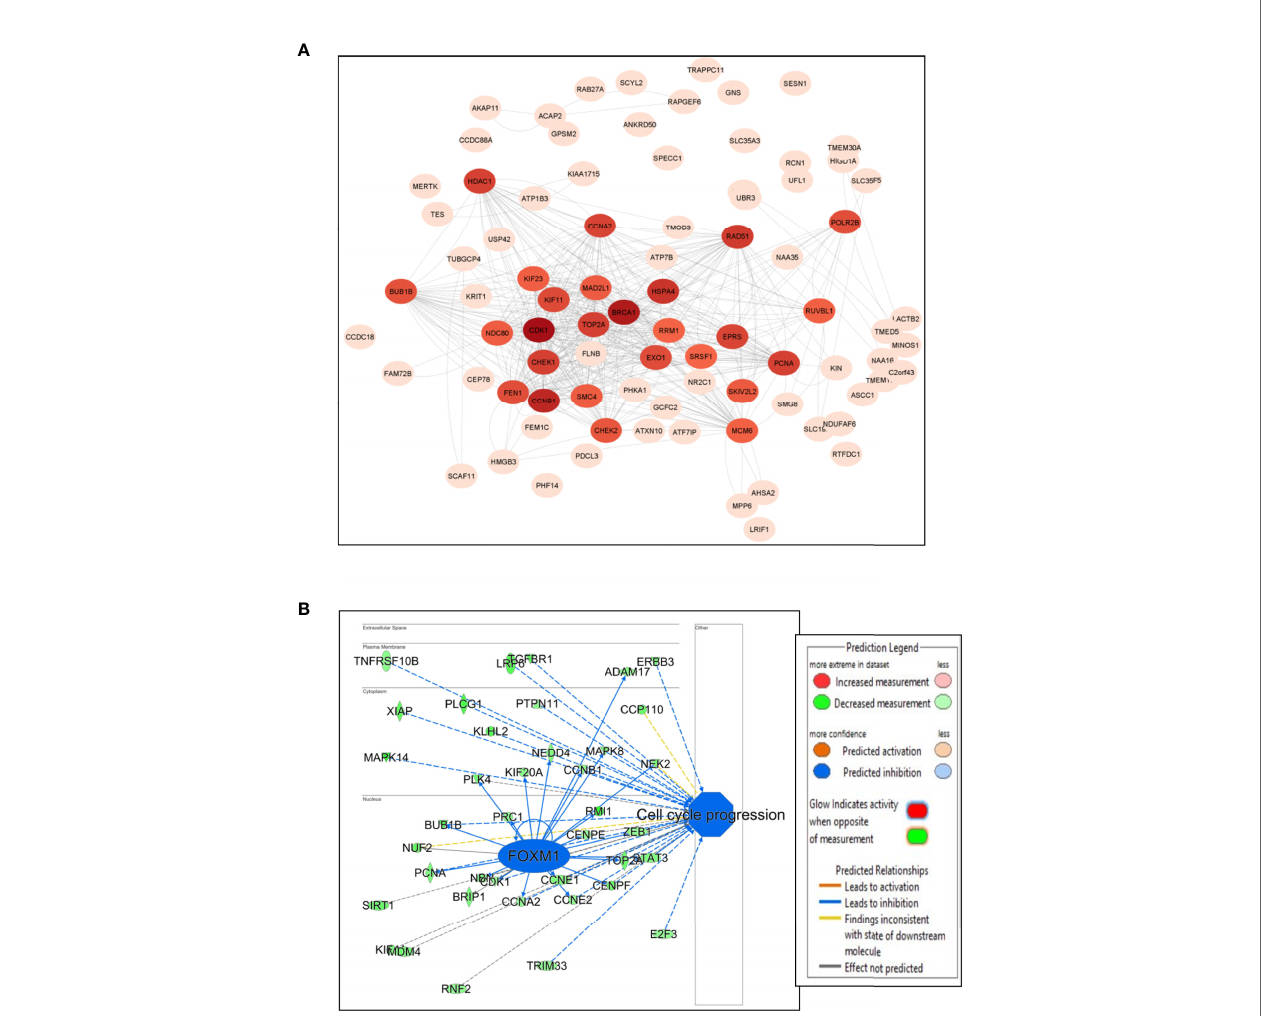
FIGURE 3 | Network and pathway analysis. (A) Protein-protein interaction network using Cytoscape. The color intensity of the circles with genes depends on the number of connections with intense color (hub genes) having large number of connections and light color with less connections. (B) IPA transcriptional analysis of FOXM1 and its interaction and connectivity with other differentially expressed genes in the network. The predicted inhibition of FOXM1 likely inhibits cell cycle